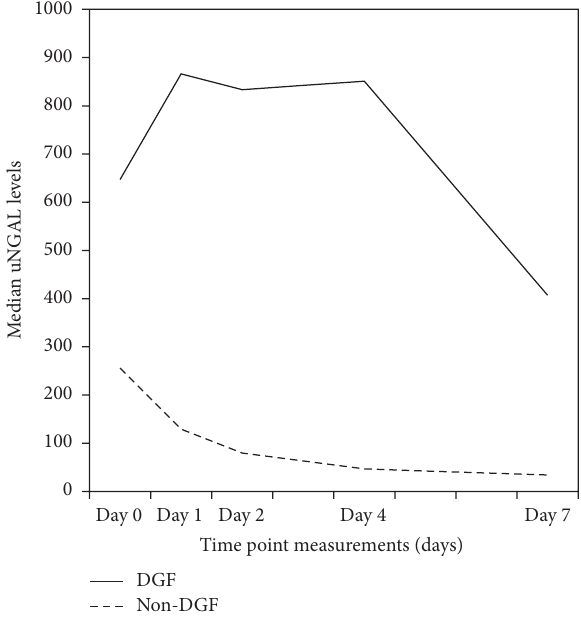
Figure 1: Evolution of uNGAL levels through first week after transplantation,accordingtograftfunction.Abbreviations:uNGAL: urinary neutrophil gelatinase associated lipocalin; DGF: delayed graft function.